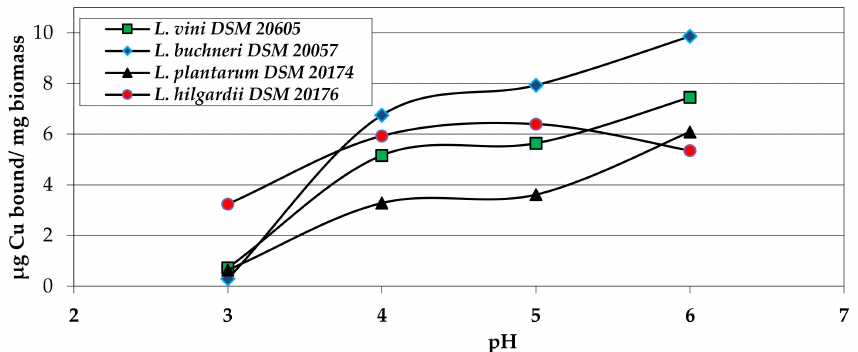
Figure 2. E ff ect of the matrix pH on the copper binding capacity of wine-relevant Lactobacillus species. Conditions: Deionized water with 40 µ g Cu 2 + / mL, biomass concentration 1 mg / mL (boiled cells), and incubation time 30 min